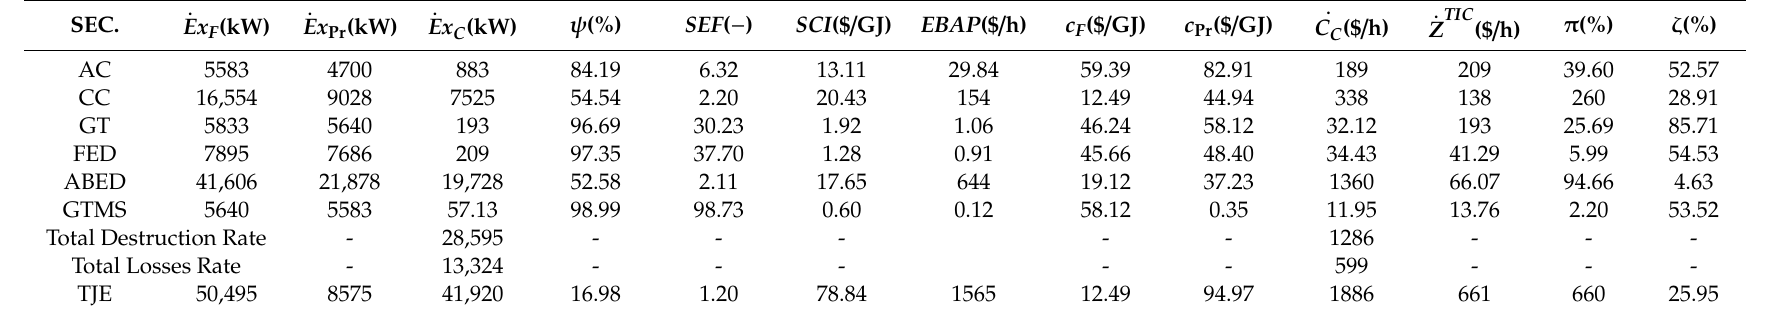
Table 11. Results for exergy, exergoeconomic and sustainability performance indicators for AB PM with kerosene fuel